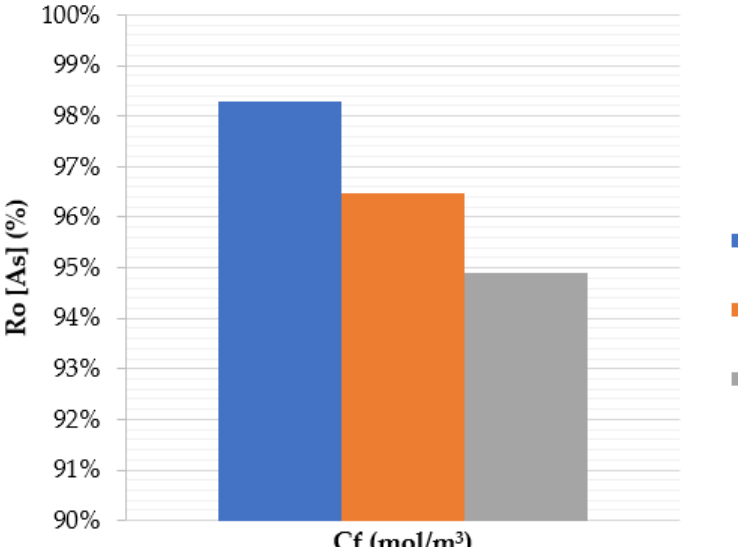
Figure 9. Pb salt rejection for the composition studied.